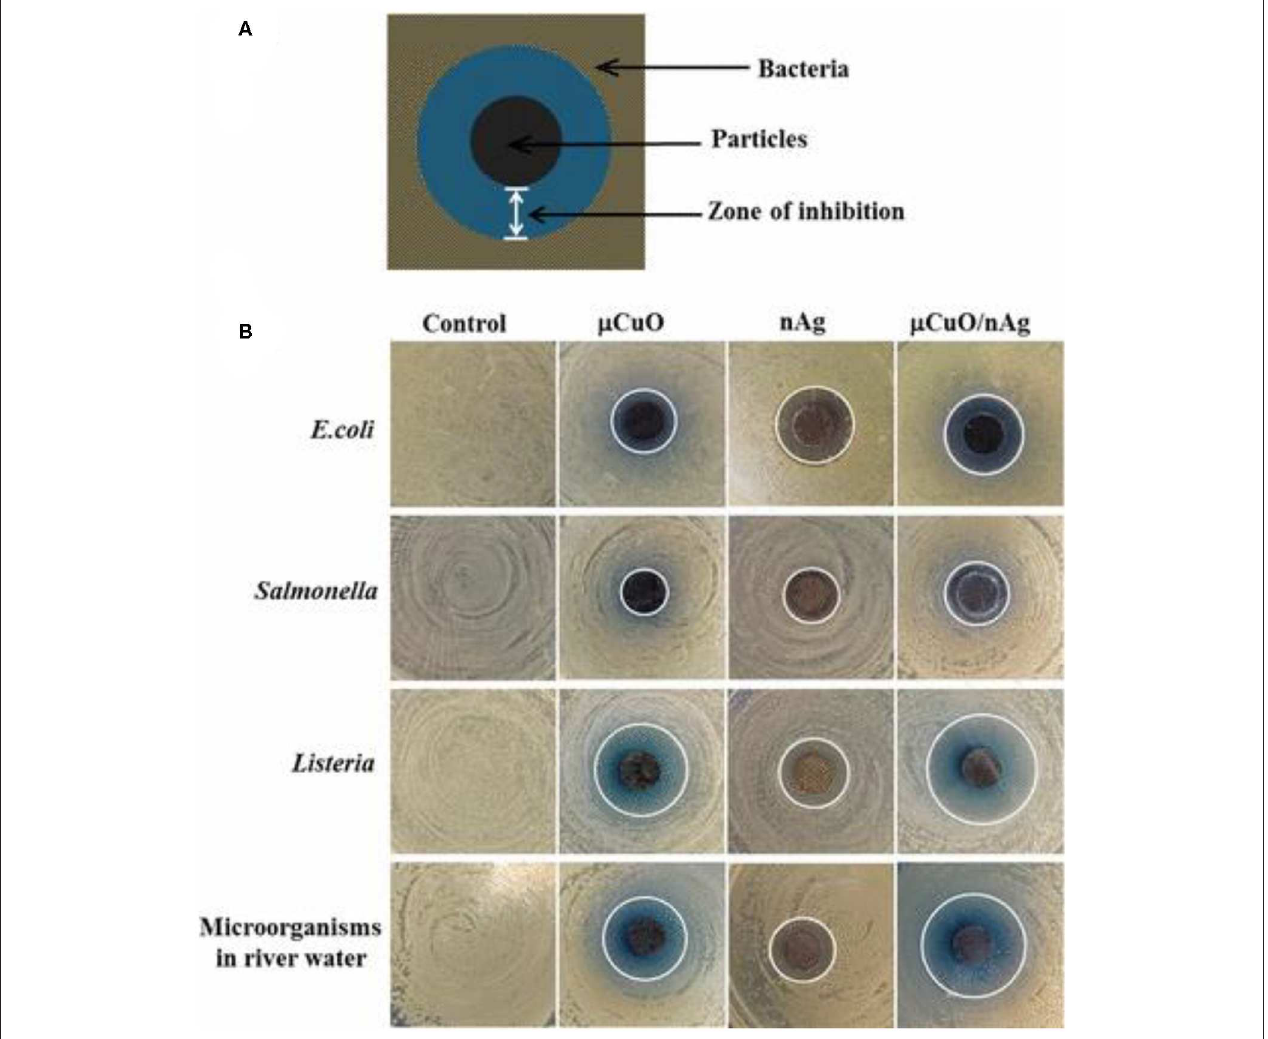
FIGURE 7 | (A) Schematic diagram representative of the observed inhibition zone using bimetallic porous CuO decorated with Ag nanoparticles and (B) photographs of the inhibition zone with each particle type against Gram-negative bacteria E. coli and Salmonella , Gram-positive bacteria Listeria , and environmental microorganisms derived from river water. Note that the white lines mark the boundary of the inhibition zones; the control is a negative control without particles. Reproduced from Chen et al. (2017) with permission from the American Chemical Society.